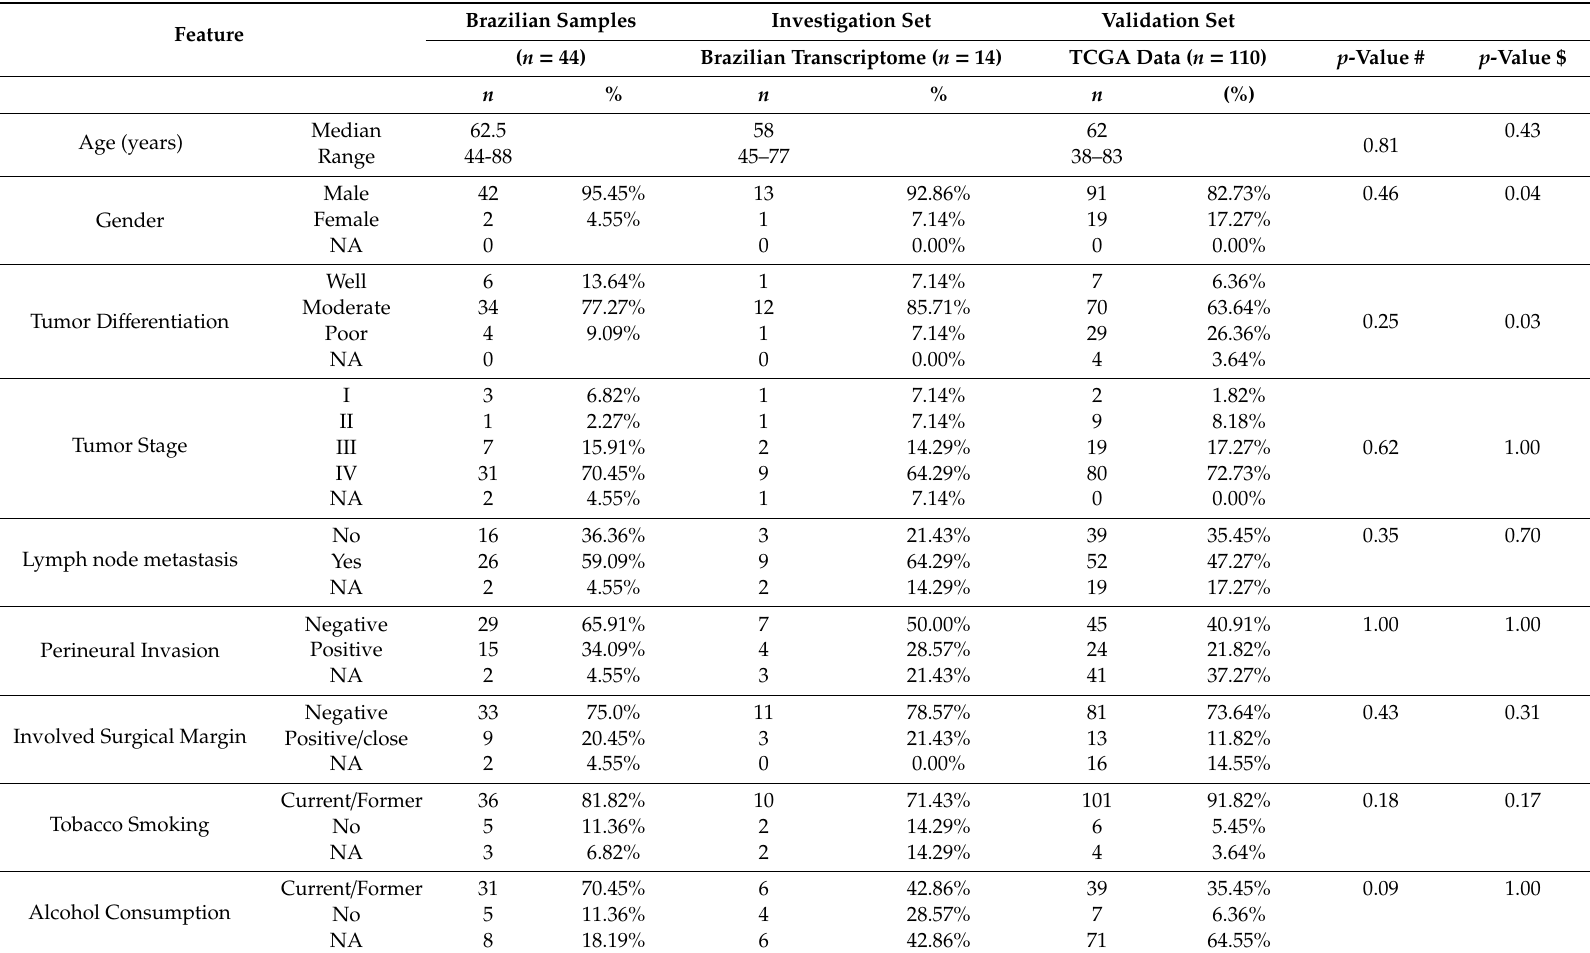
Table 3. Clinicopathological data of investigation and validation set of